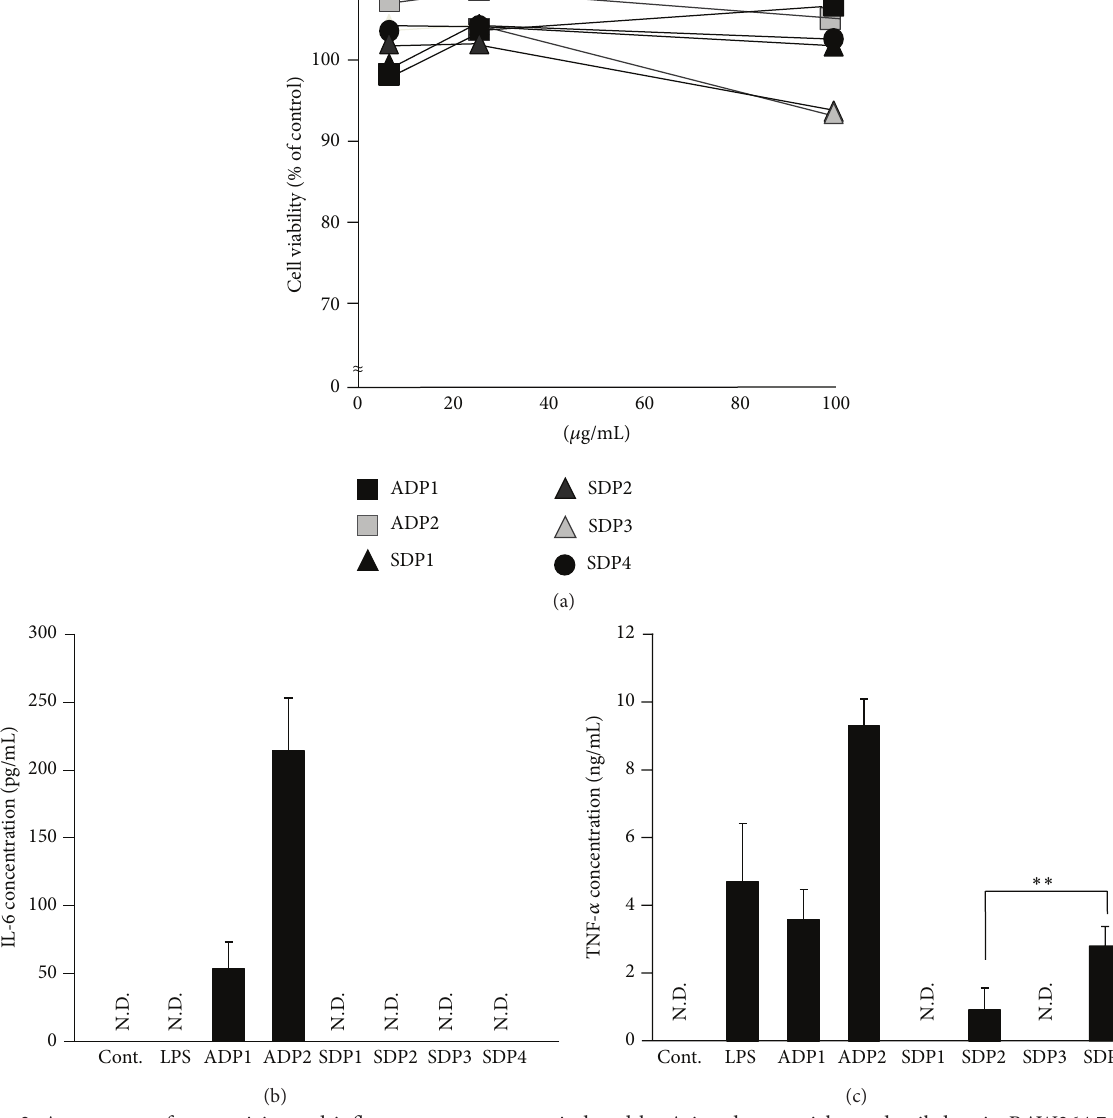
Figure 2: Assessment of cytotoxicity and inflammatory responses induced by Asian dust particles and soil dust in RAW264.7 cells. (a) RAW264.7 cells were treated for 24 h with 6.25, 25, or 100 𝜇 g/mL of Asian dust particles ADP1, ADP2, or with soil dust SDP1, SDP2, SDP3, or SDP4 (particle diameter, ≤ 10 𝜇 m). Cell viability was assessed by means of a methylene blue assay. (b, c) RAW264.7 cells were treated with 100 𝜇 g/mL of each dust sample or 1.5 𝜇 g/mL of lipopolysaccharide (LPS) for 24 h. Levels of interleukin-6 (IL-6) (b) and tumor necrosis factor- 𝛼 (TNF- 𝛼 ) (c) in culture supernatants were assessed by means of enzyme-linked immunosorbent assay. DMEM was used as control (Cont.). Results are expressed as mean ± SD; 𝑛 = 6 ; ∗∗ 𝑃 < 0.01 ; N.D., not